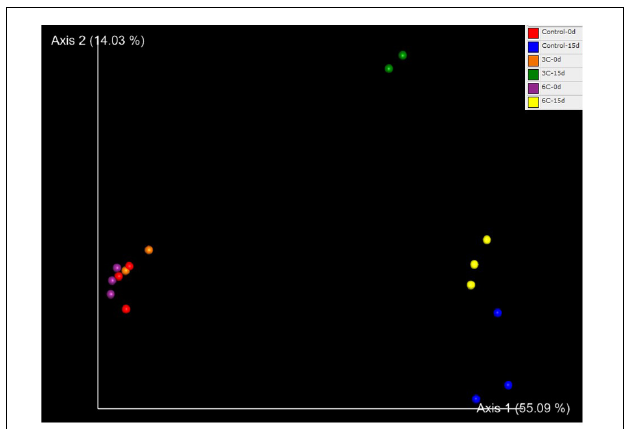
FIGURE 3 | Principal coordinate analysis of prokaryotic OTUs associated with Isodictya kerguelenensis exposed to different experimental conditions.